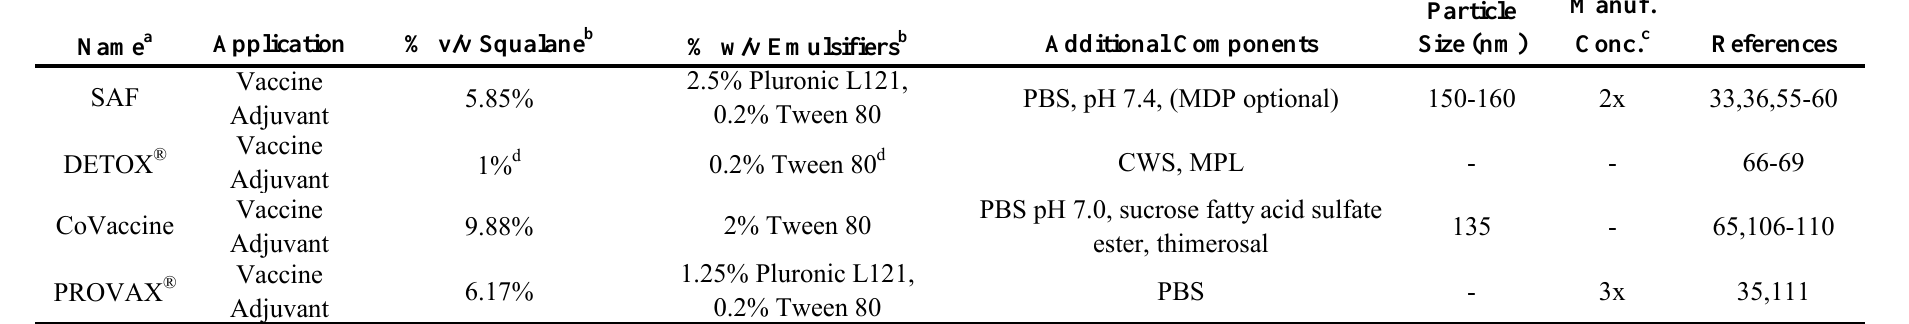
Table 3. Composition of squalane oil-in-water parenteral emulsions.